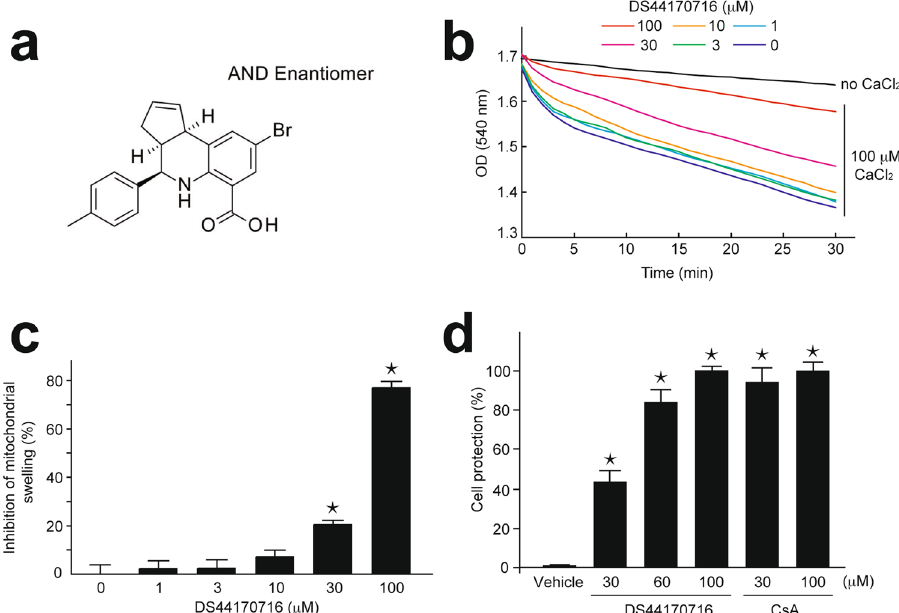
Figure 1. DS44170716 inhibits mitochondrial permeability transition. ( a ) Structure of DS44170716. ( b ) Effect of DS44170716 on mitochondrial swelling. Representative temporal profiles are shown. ( c ) Inhibition rate of mitochondrial swelling by DS44170716. The levels of OD (540 nm) 30 min after application of CaCl 2 were used for the inhibition rate. Inhibition 0% or 100% was defined as CaCl 2 -treated vehicle data or no CaCl 2 data, respectively. Data obtained from 3 independent samples are shown as the mean with SEM. ( d ) Effects of DS44170716 on Ca 2 + -induced death in HepG2 cells. Cell death levels were measured by LDH released from the cells. Cell protection 0% or 100% was defined as the mean of vehicle data or mean of 100 μ M CsA, respectively. Raw data are presented in Supplemental Fig. 1. Data obtained from 4 independent samples are shown as the mean with SEM. Asterisk shows P < 0.05 compared to vehicle group (Dunnett’s